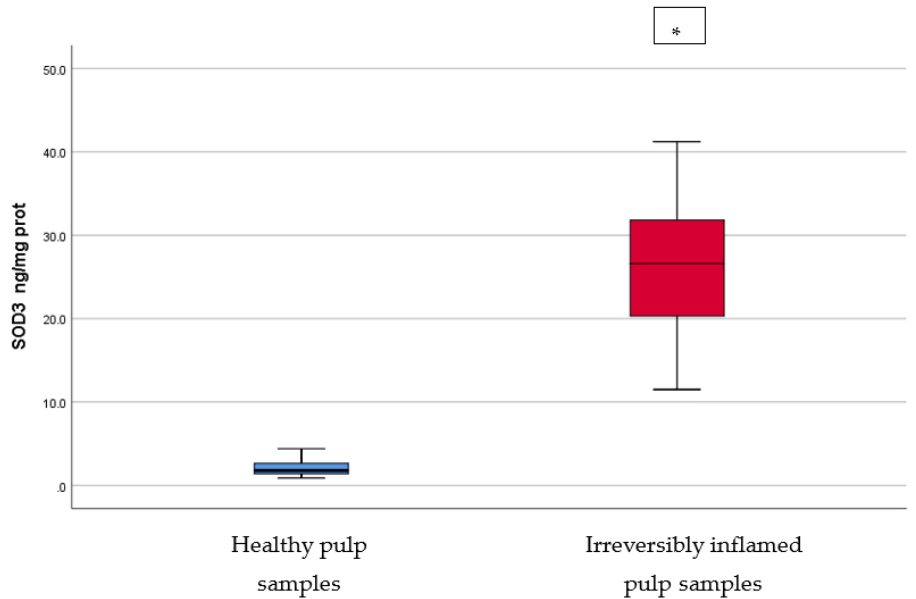
Figure 4. Comparison of SOD3 levels (ng/mg protein) in healthy and irreversibly inflamed dental pulp samples, respectively. The distribution of variables is parametric in both groups according to the Shapiro–Wilk test ( p > 0.05). Welch’s t -test shows that the differences between the two groups are statistically significant ( p < 0.001). (* indicates a statistically significant difference).